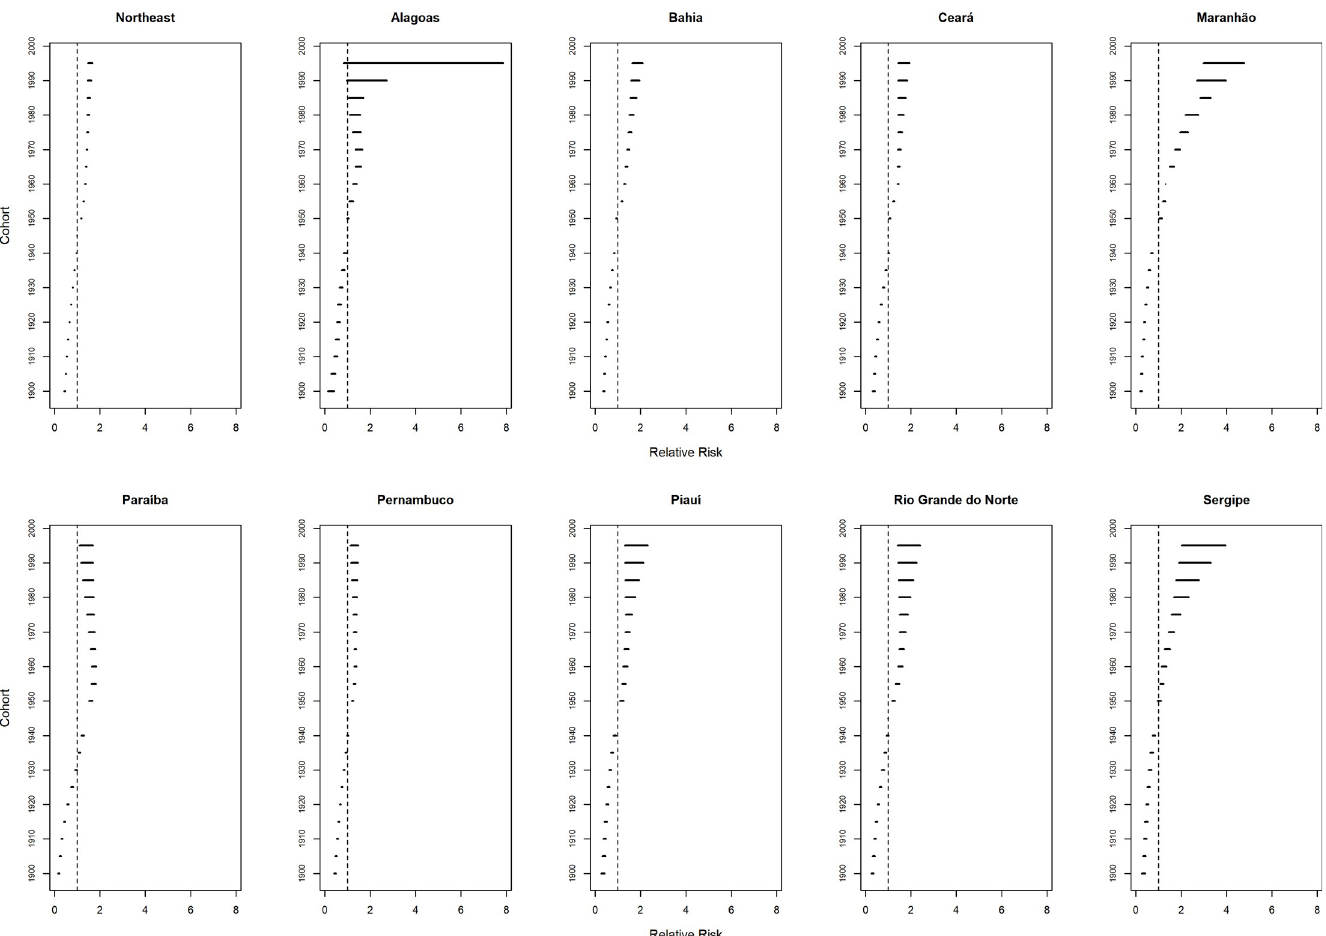
Fig 9. Results of the age-period-cohort model adjusted for breast cancer mortality according to the cohort effect in north-eastern states, Brazil,